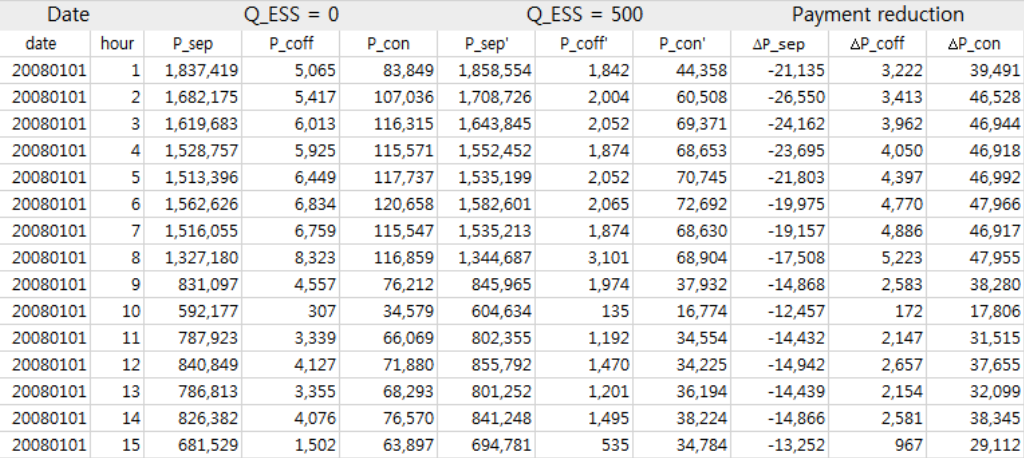
Figure 4. Simulation outputs (unit: $).